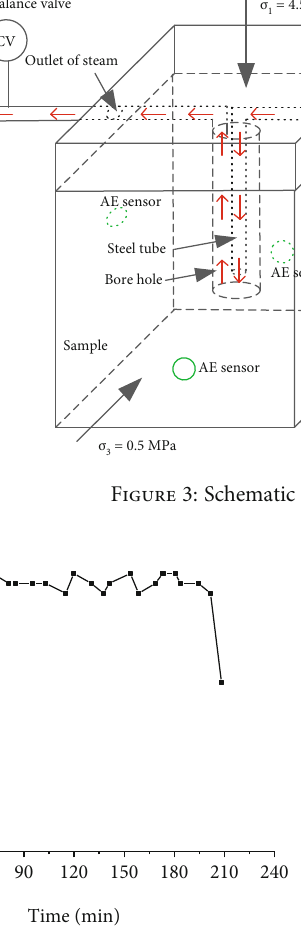
Figure 4: Injection steam pressure-time